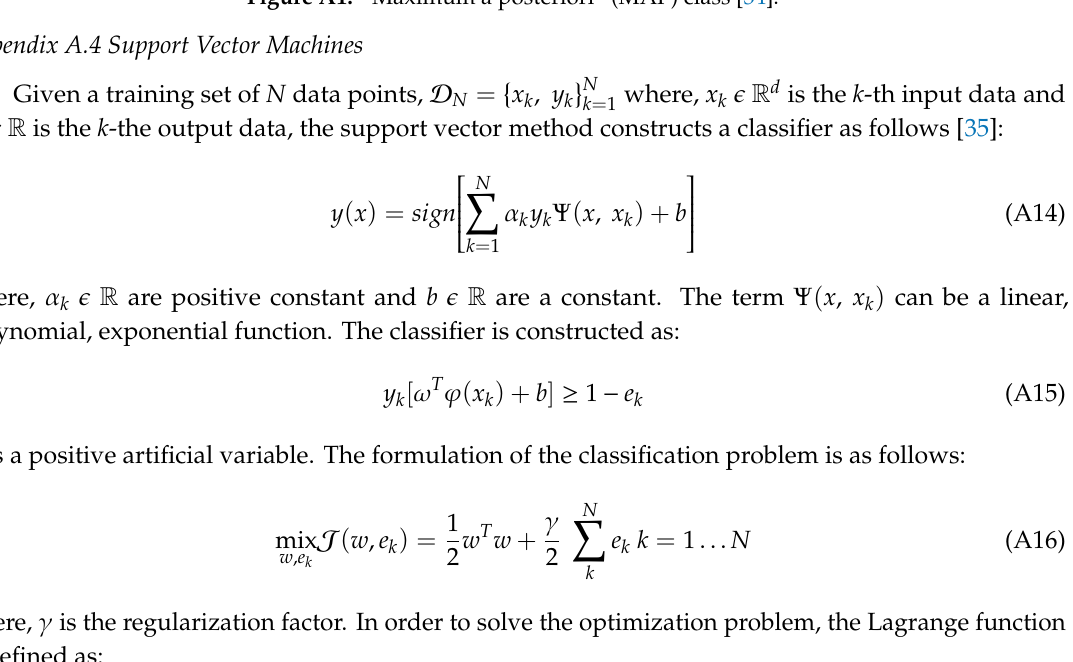
Figure A1. “Maximum a posteriori” (MAP) class [34].